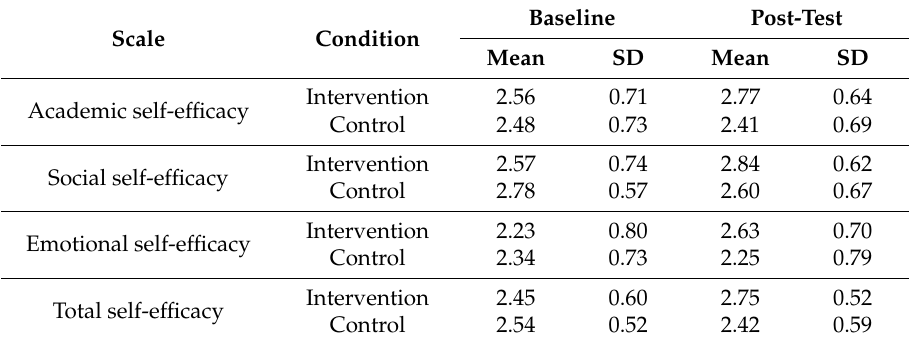
Table 6. Means and standard deviations for SEQ-C self-efficacy scales by experimental condition.